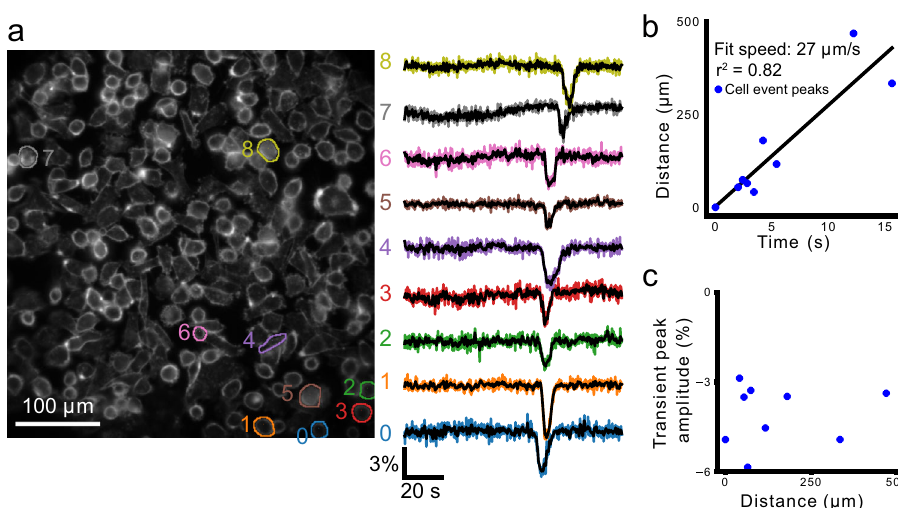
Fig. 10 A wave of transient hyperpolarizations propagates across the FOV. a Shows cellular ROIs and their color-corresponding Δ R / R 0 time series (right). b Plots distance from the fi rst cell as a function of time at maximum hyperpolarization. The line fi t to this relationship shows a propagation speed of 27 μ m/s. c Plots the peak transient amplitude (% Δ R / R 0 ) as a function of distance from the cell fi rst showing the transient